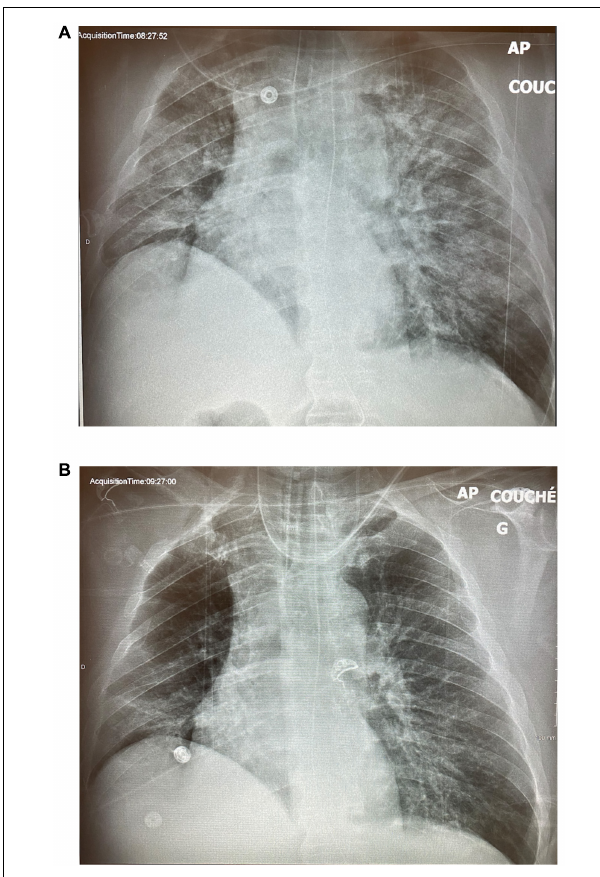
FIGURE 8 | Case 3: (A) CXR on ICU Day 3, after 24 h of APRV-TCAV(tm). (B) CXR on ICU Day 6.